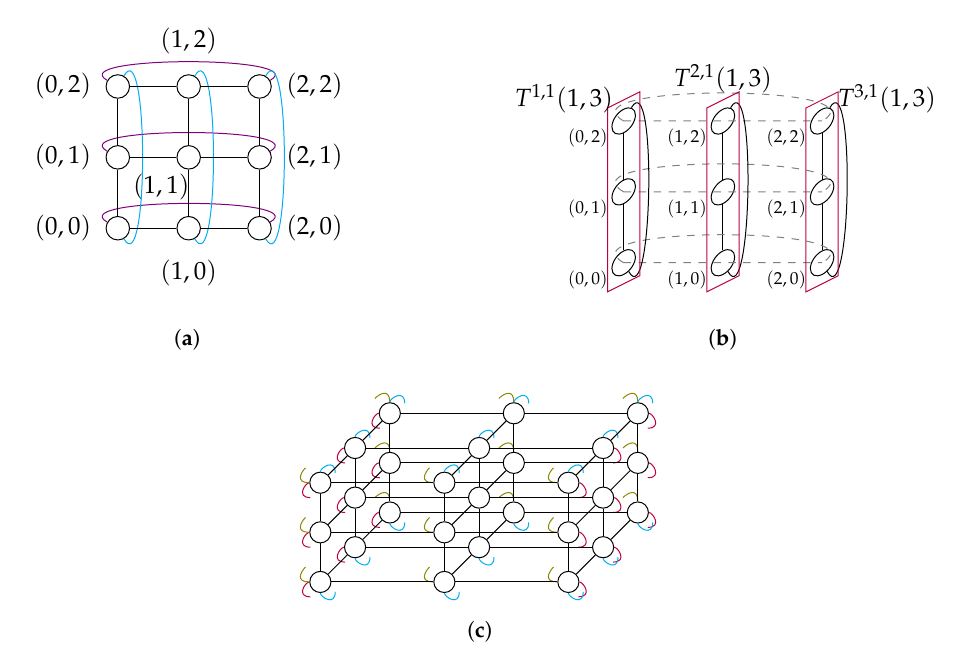
Figure 2. ( a ) A 2-dimensional 3-ary torus T ( 2,3 ) . ( b ) Illustration of the recursive structure of a torus: a T ( 2,3 ) consists in three 1-dimensional 3-ary sub-tori T ( 1,3 ) . ( c ) A 3-dimensional 3-ary torus T ( 3,3 )